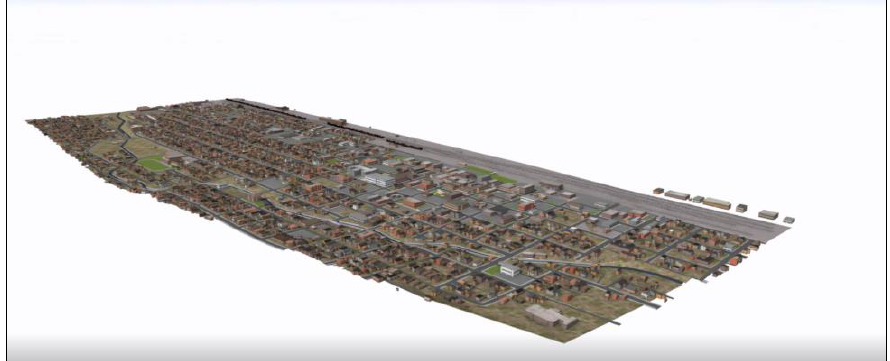
Figure 6. CityEngine 3D model of Old Town Pocatello in ArcGIS Online.